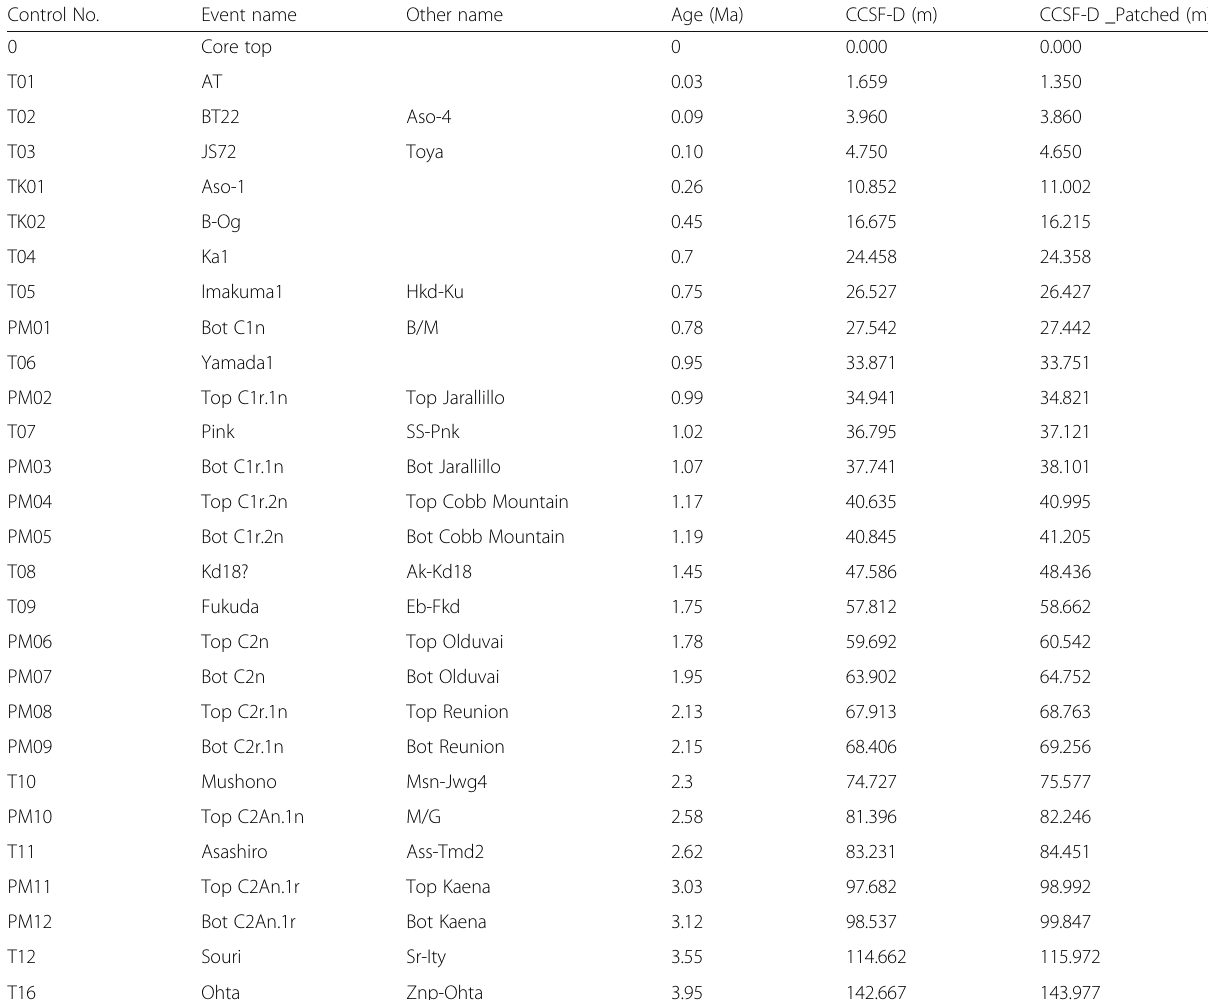
Table 1 A list of tephras and magnetostratigraphic events, their composite depths (CCSFD_patched), ages, and references used to construct a tephra and p-mag based age model shown in Fig. 2 Control